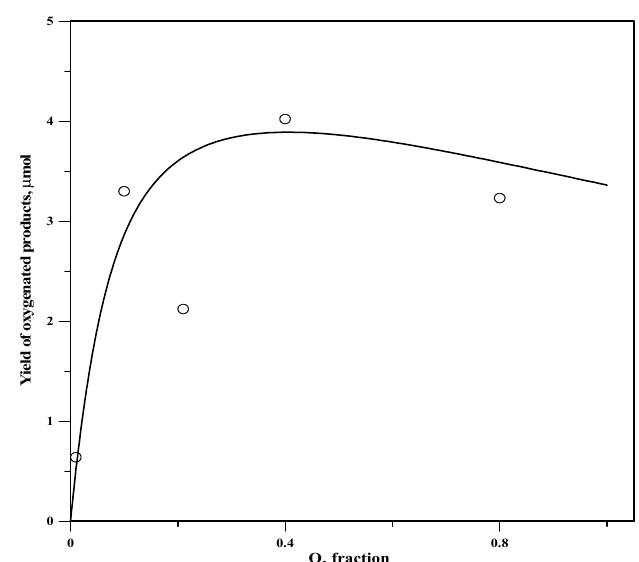
Figure 3. Yield of cyclohexanol plus cyclohexanone following the 20-min. photolysis (100 W Hg lamp, λ > 360 nm) of 1 mL of cyclohexane (with 0.5% acetic acid and 1 mg Bu 4 NBr) with balloons containing different percentages of O 2 . Solid line is a fit to Equation (9) with b = 0, c = 1.38, d = 150.